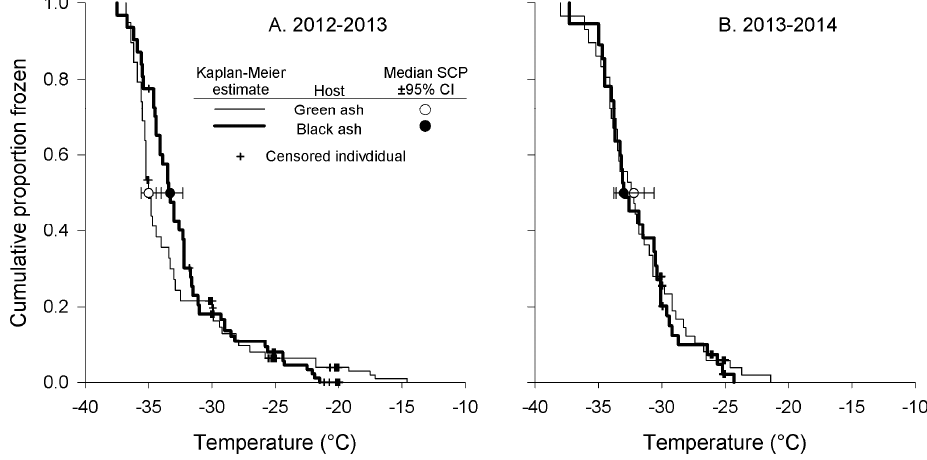
Figure 1. Kaplan-Meier estimates of the likelihood that an A. planipennis larva will begin to freeze (i.e., give a supercooling point) after exposure to a particular temperature, by tree species, in ( A ) the winter of 2012-2013 and ( B ) the winter of 2013-2014. Censored individuals did not start to freeze by their lowest exposure temperature.